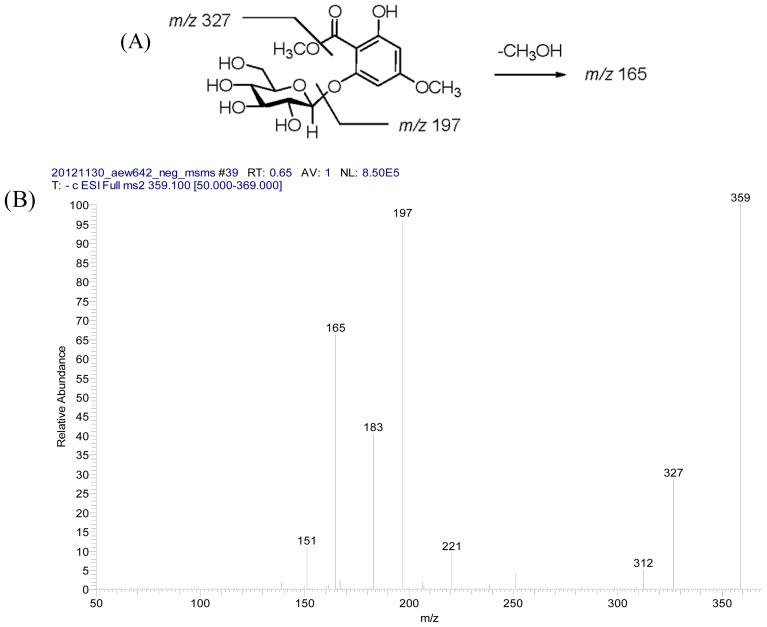
(A) Structure of 3 and main fragments under LC/MS/MS (negative ESI); (B) LC/MS/MS spectrum.